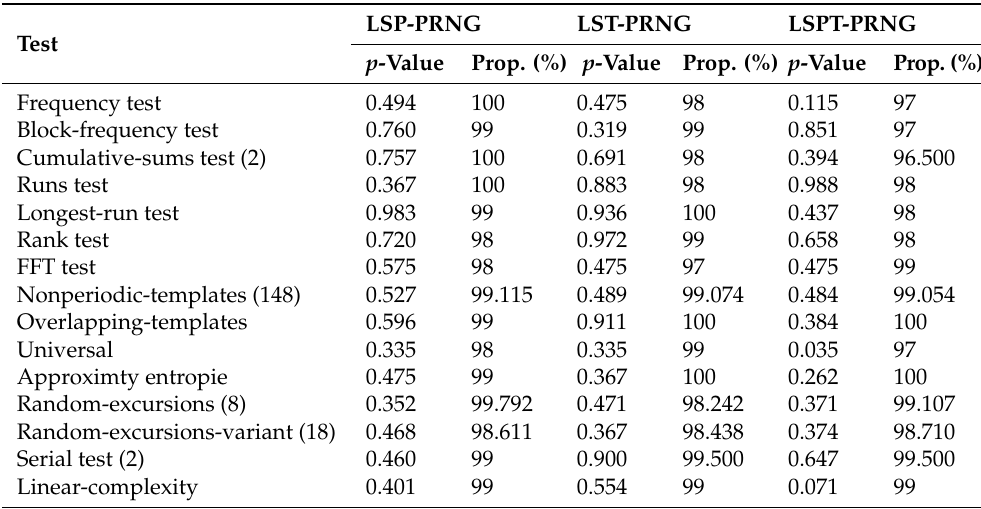
Figure 11. NIST test results of the proposed PRNGs-CS. ( a ) NIST test for LSP-PRNG. ( b ) NIST test for LST-PRNG. ( c ) NIST test for LSPT-PRNG. Table 5. p -values and Proportion results of NIST test for the proposed